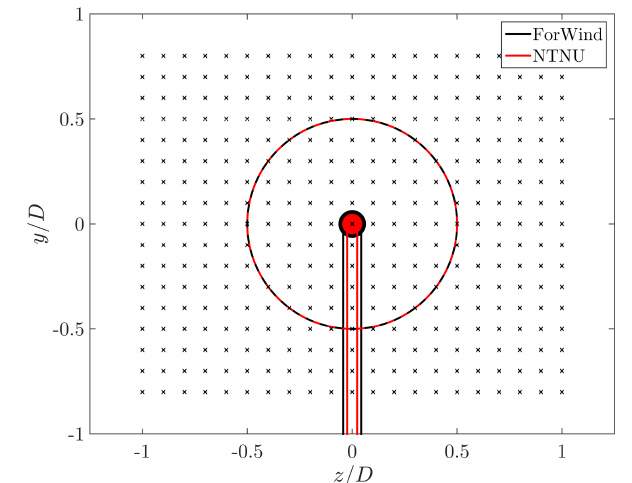
Figure 3. Non-dimensional measurement grid behind the rotor for γ = 0 ◦ . The respective contours of the turbines are shown in black (ForWind) and red (NTNU). For the NTNU turbine the wind tunnel walls are located at z/D = ± 1 . 5 and y/D = ± 1 . 0; for the ForWind turbine they are located at z/D = ± 2 . 34 and y/D = ± 1 . 56.